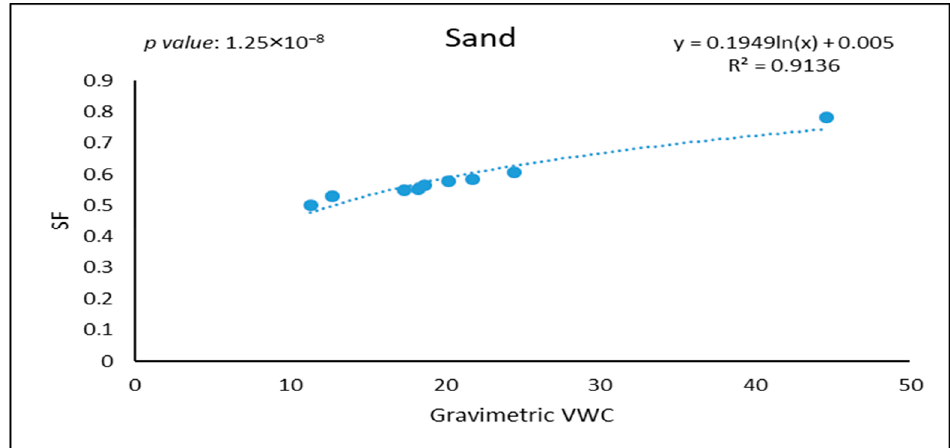
Figure 9. Fitting regression analysis of phase two field calibration. Table 6. Statistical metrics for the Phase 2 sand calibration.